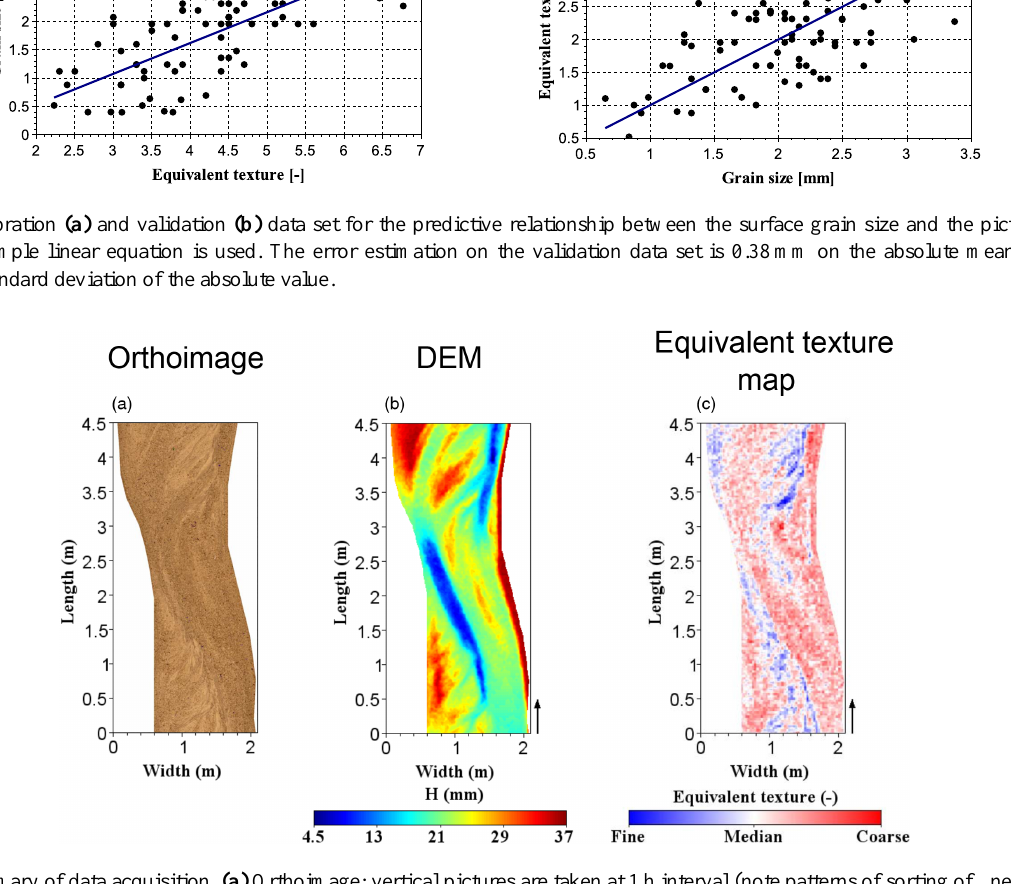
Figure 2. Summary of data acquisition. (a) Orthoimage: vertical pictures are taken at 1h interval (note patterns of sorting of fine and coarse material). (b) DEM: the topography is derived photogrammetrically, the cell size is 3mm, and the flume slope is removed. (c) Equivalent texture map: the map is derived from the texture calculation of vertical pictures, and the median grain size error is less than